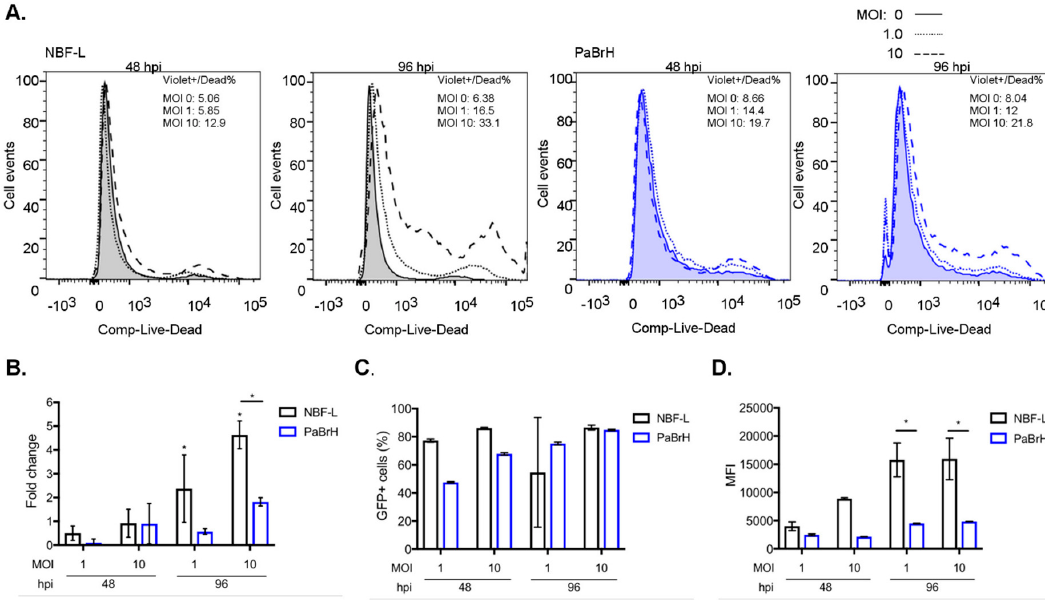
Figure 2. ABLV infection induces less cell death in black flying fox cells. ( A ) Histogram overlays LIVE/DEAD Violet stained NBF-L and PaBrH cells after rABLV-GFP infection. Percentages of Violet + dead cells are demarcated for hpi and MOI indicated. ( B ) Percentage of dead cells expressed as a fold change compared to MOI 0 at each time point. Data are a representative of three independent experiments, * p < 0.05, ANOVA (two-way), and Tukey’s multiple comparison test. ( C ) Percentage of GFP positive cells at 48 and 96 hpi. ( D ) Median fluorescence intensity (MFI) of ABLV expressed GFP. Data ( C – D ) are representative of two independent experiments, mean ± SEM, * p < 0.01, ANOVA (two-way), and Tukey’s multiple comparison